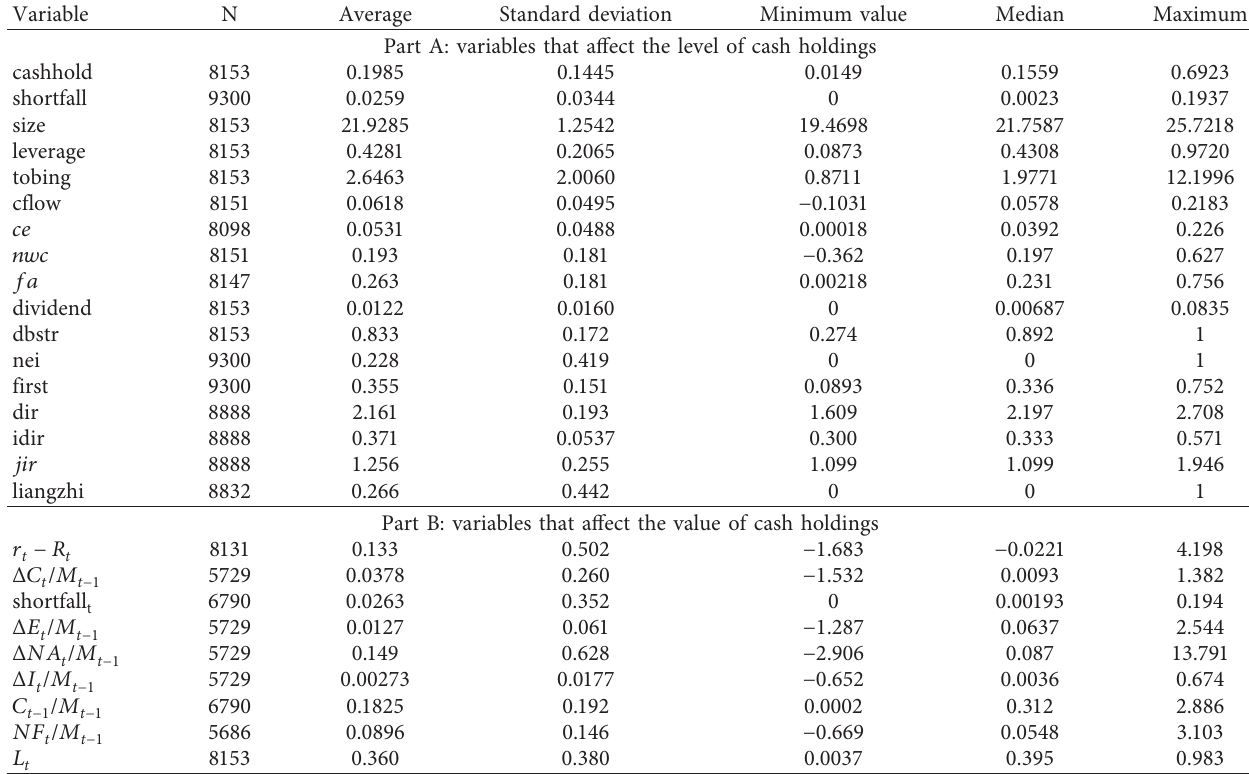
Table 2: Descriptive statistics of the main